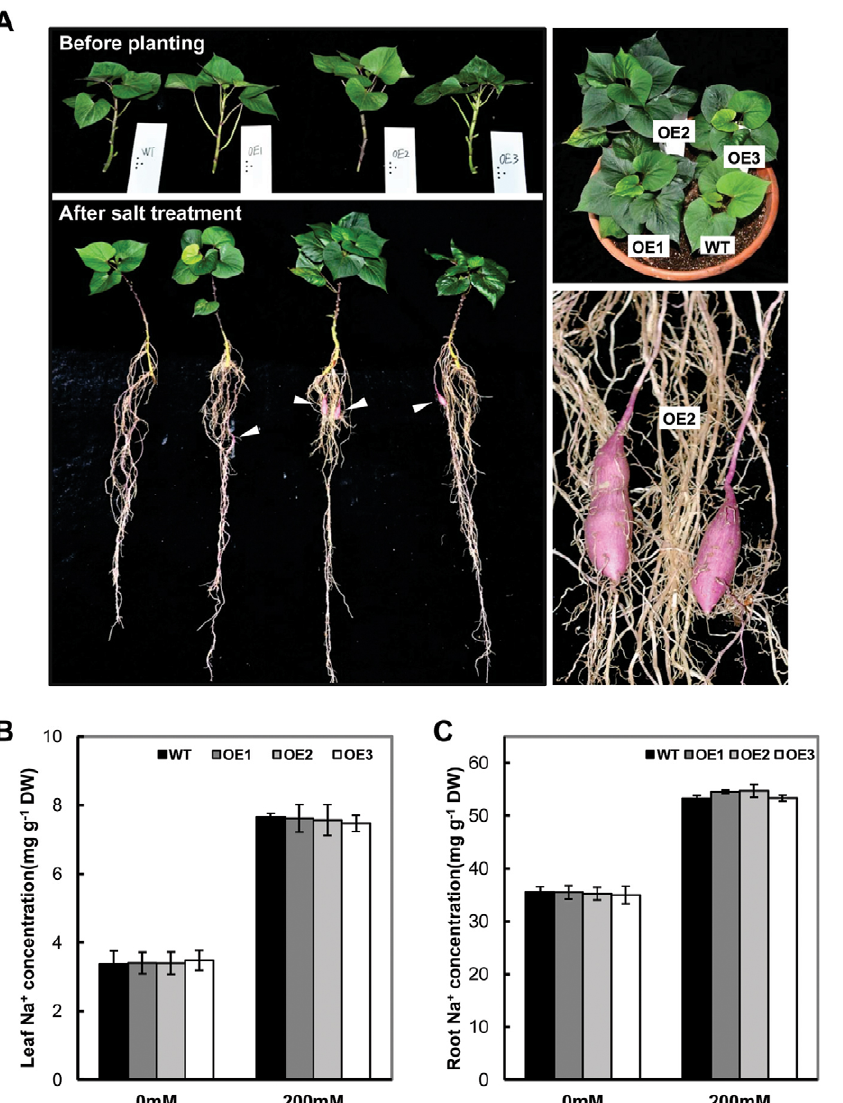
Figure 4. The growth and Na + levels of SoBADH transgenic plants under 150 mM salt stress treatment for 6 weeks. A, transgenic OE lines showed distinguishable differences from WT on foliage and root growth after 150 mM salt stress. B–C, Na + level in leaves and roots of WT and transgenic plants. Values represent the mean 6 SD (n=9). Asterisks indicate a significant difference from that of WT at * P , 0.05 or ** P , 0.01 by t - test.